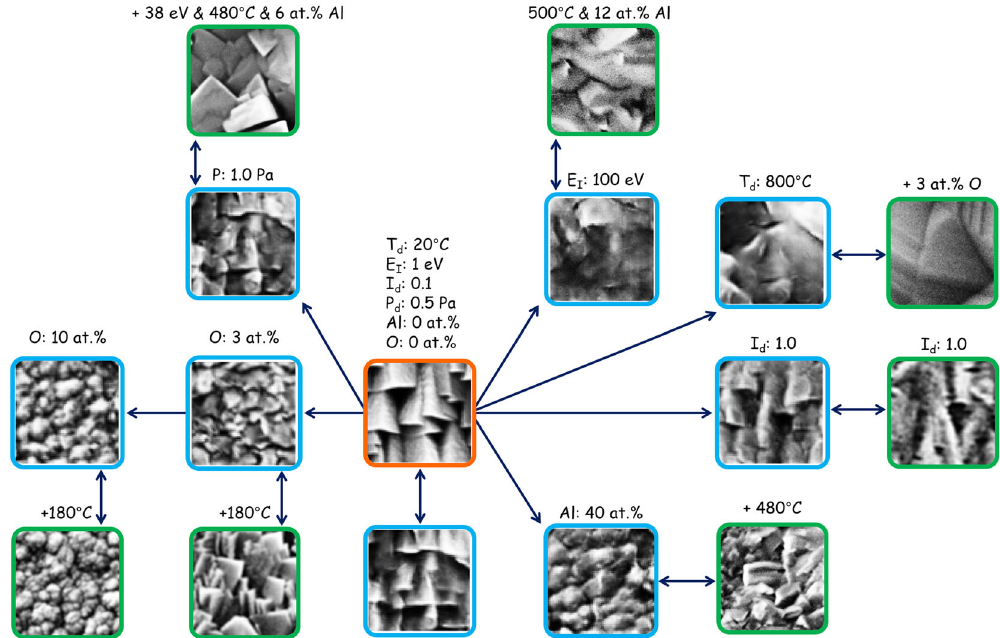
Fig. 4 Predicted microstructures from cGAN and comparison with experimental results. Predictions (blue frame) are based on the experimental microstructure of Cr – N deposited at room temperature (orange frame) with corresponding conditional parameters. The changed parameter for each predicted or experimental image (green frames) is indicated while all other parameters stay constant. If an experimental counterpart with identical conditional parameters is missing, the closest related experimental image is selected and the additional change in conditional parameters is marked above the image (e.g., + 480 °C).